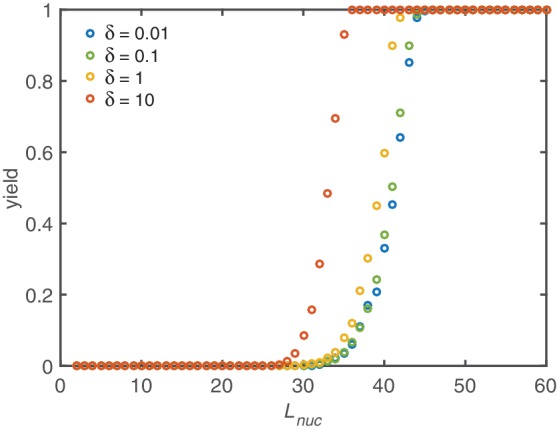
Yield maximization due to increased nucleation size.Without activation and dimerization mechanism (α→∞,μ=ν) the yield can still be optimized by increasing the critical nucleation size Ln⁢u⁢c. However, a significant improvement is only achieved for critical sizes larger than half the ring size. Above, a rapid transition to perfect yield takes place. Below no effect is observed at all. Increasing δ shifts the onset of yield to slightly smaller critical nucleation sizes. Other parameters: L= 60, N= 10000.